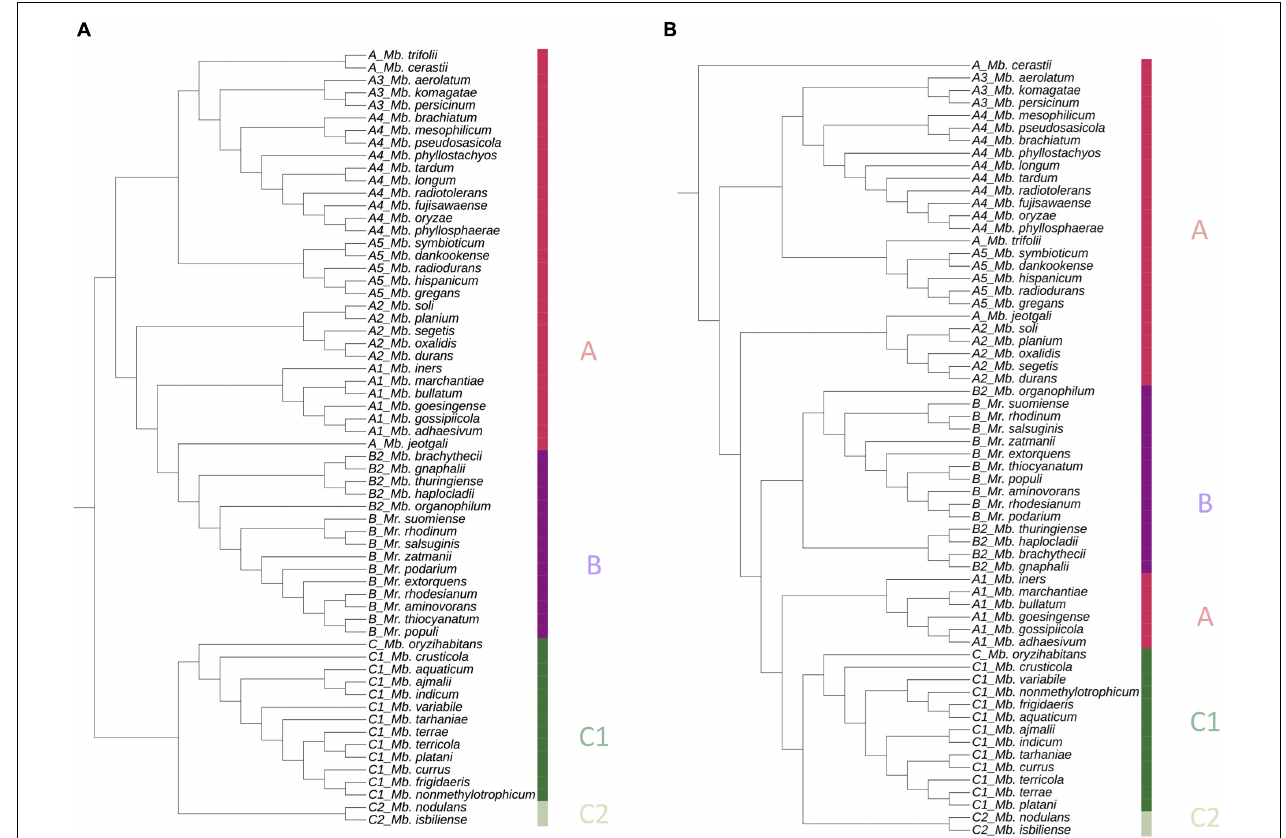
FIGURE 2 | Phylogenetic trees based on (A) pan matrix, binary gene presence, and absence matrix (1/0) and (B) concatenated sequences of core 711 proteins from the 62 PPFMs. Both trees are generated with BPGA pipeline, and presented with iTOL. The color bar indicates each strain’s